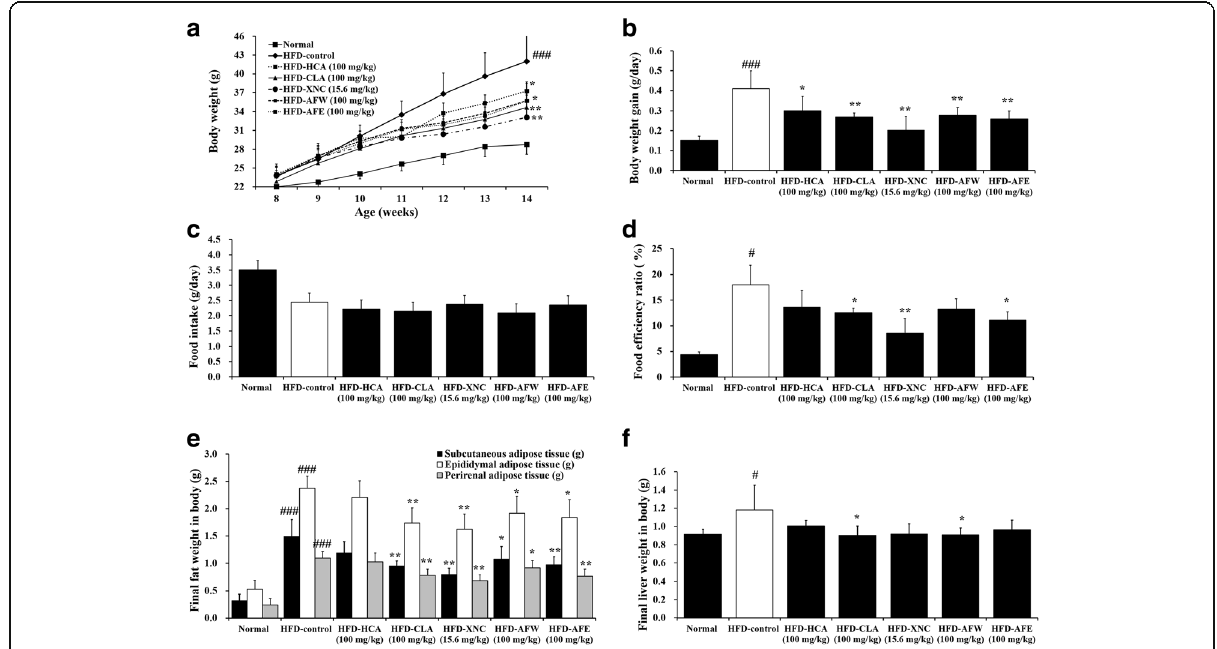
Fig. 2 Effect of 6-week treatment with Allium fistulosum aqueous extract (AFW) and A. fistulosum ethanolic extract (AFE) in high-fat diet (HFD)-fed mice. a Body weight, ( b ) body weight gain, ( c ) food intake, ( d ) food efficiency ratio, ( e ) final adipose tissue weight, and ( f ) final liver weight. Normal, standard chow; HFD-control, HFD only; HFD-HCA, HFD plus 100 mg/kg Garcinia cambogia extract containing hydroxycitric acid; HFD-CLA, HFD plus 100 mg/kg conjugated linoleic acid; HFD-ORL, HFD plus 15.6 mg/kg Xenical (orlistat); HFD-AFW, HFD plus 100 mg/kg AFW; HFD-AFE, HFD plus 100 mg/kg AFE. Results are expressed as the mean ± standard error of the mean (SEM) ( n = 6). # p < 0.05, ### p < 0.001 compared with the normal control group; * p < 0.05, ** p < 0.01 compared with the HFD-control